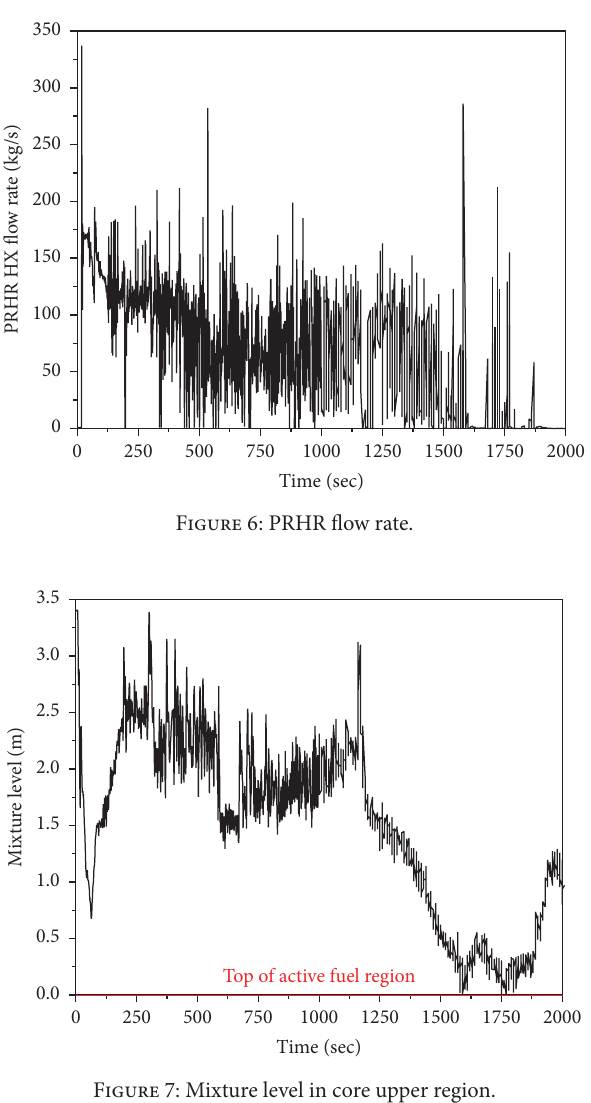
Figure 7: Mixture level in core upper region.